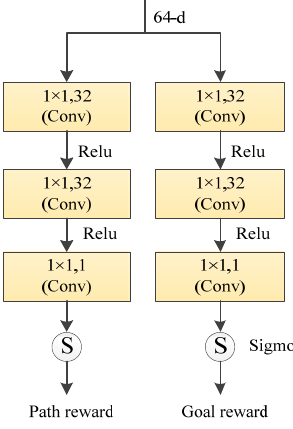
Figure 9. Path and goal reward module.